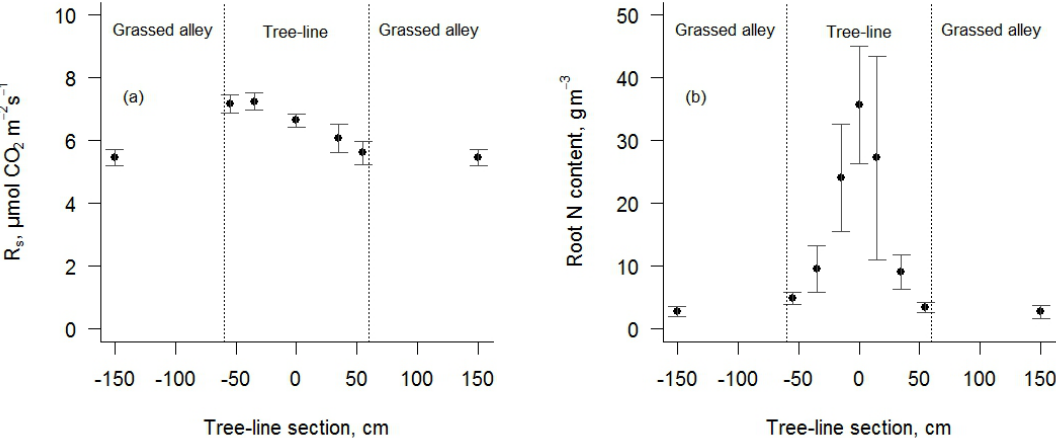
Fig. 4. Soil respiration ( a ,µmolCO 2 m 2 s − 1 ) and N content in root biomass ( b , gNm − 3 soil) measured across the treeline and the grassed alley, where “zero” indicates the position of the apple tree. Measurements were performed in the six different plots used for the spatial survey. Bars represent standard error (se) of the mean.